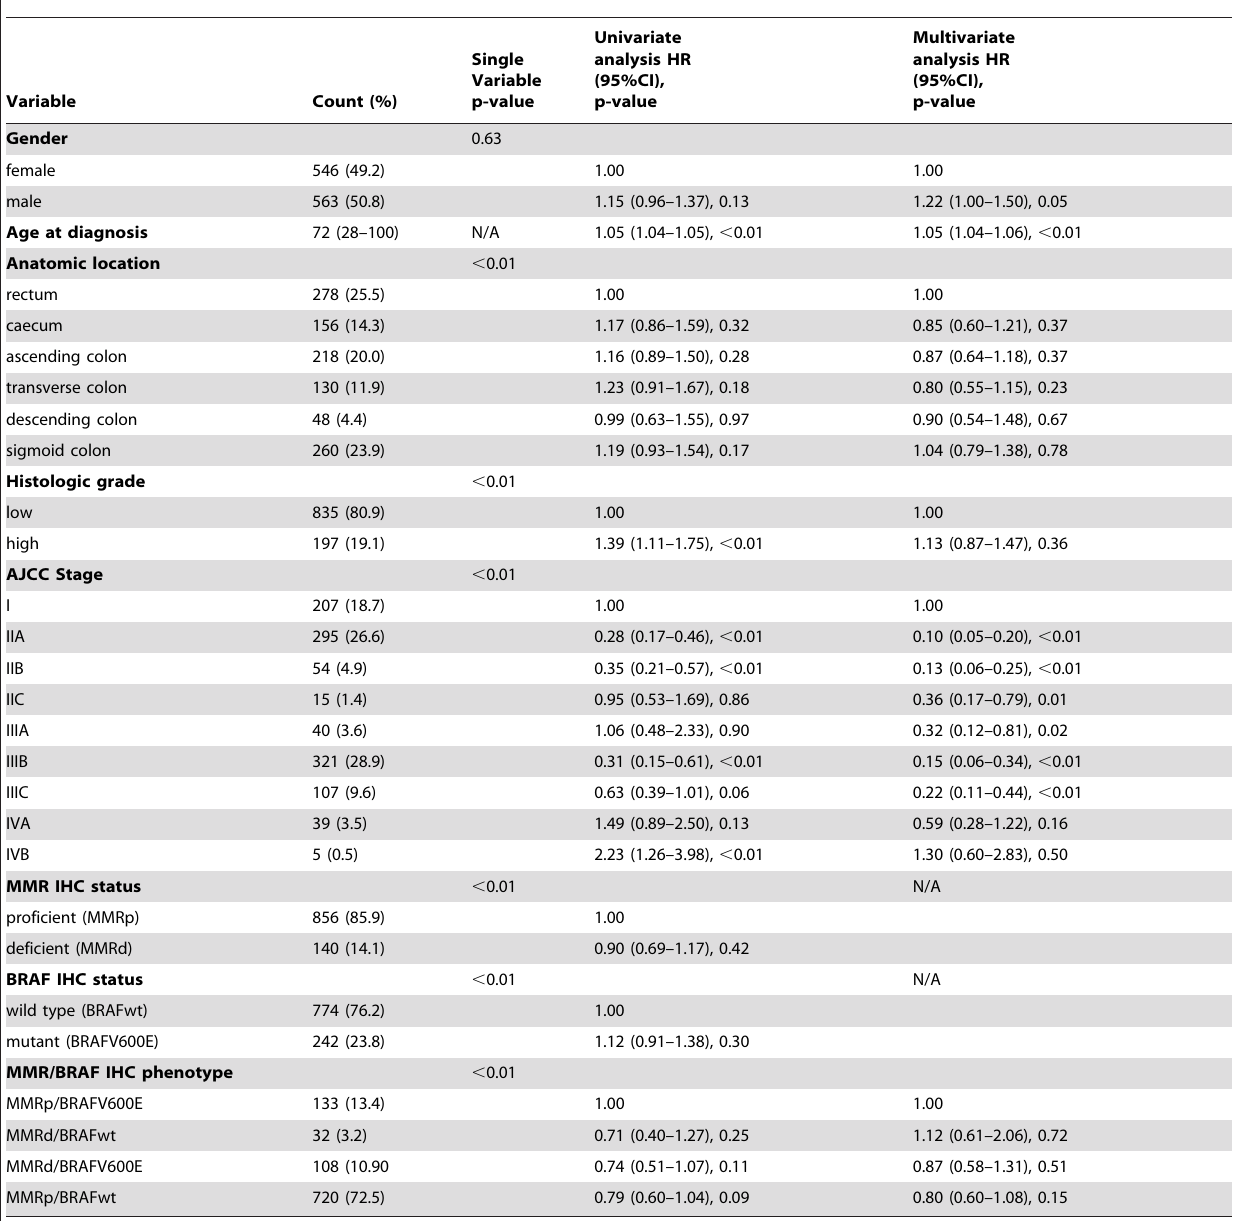
Table 1. Clinical and pathological features of 1109 consecutive patients with CRC.